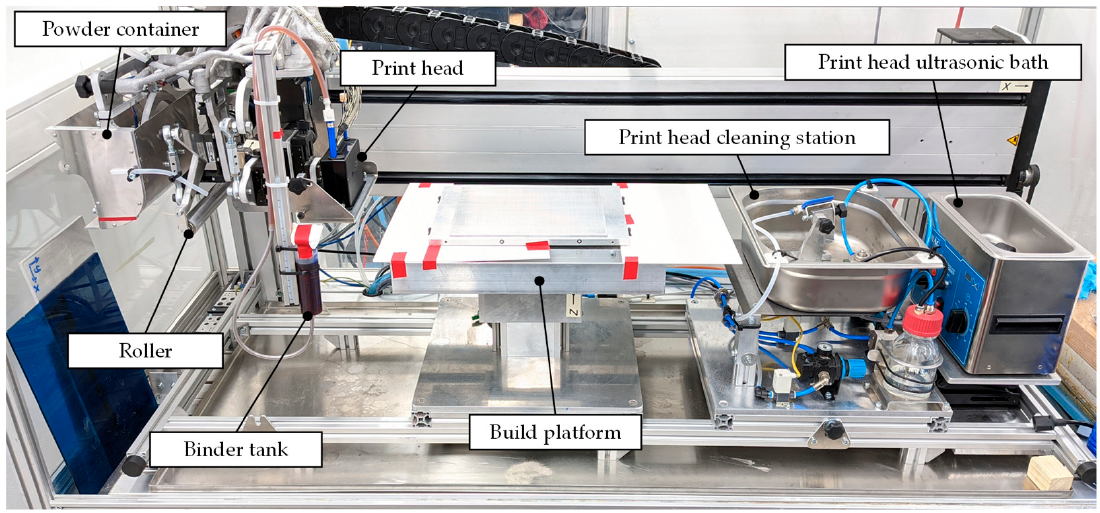
Figure 4. Binder je tt ing test setup used for the experiments.